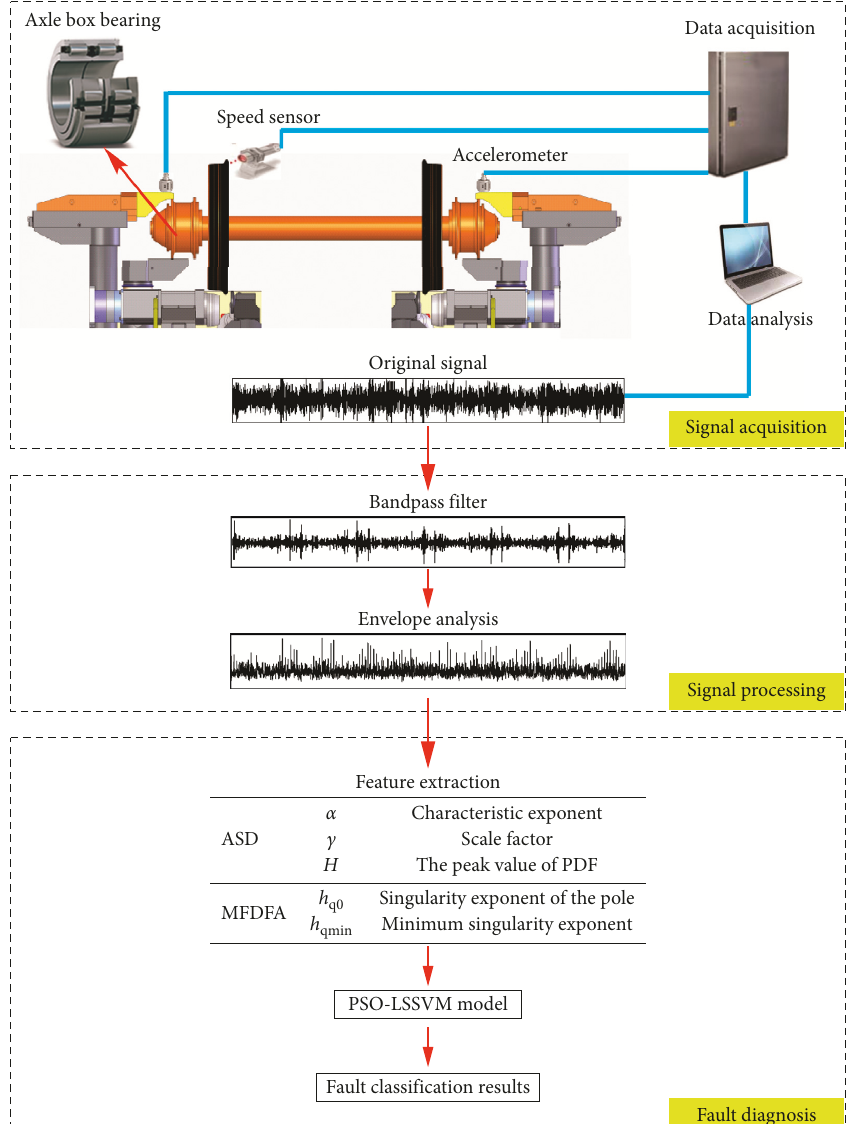
Figure 5: The process of fault diagnosis for axle box